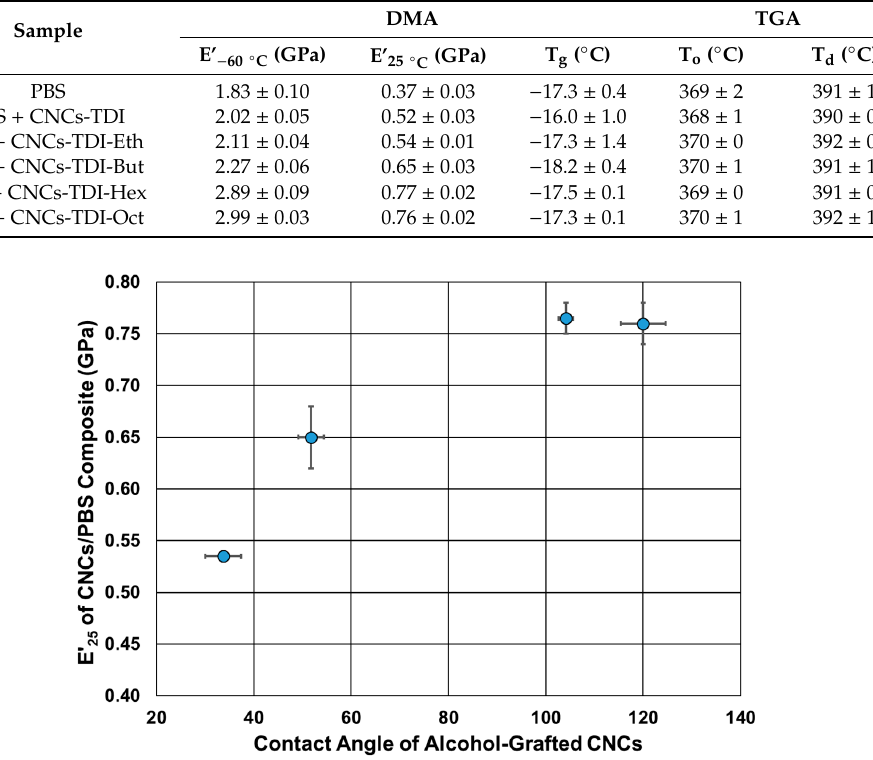
Figure 9. The relationship between the contact angle of the alcohol-grafted CNCs and their capabilities to reinforce PBS.